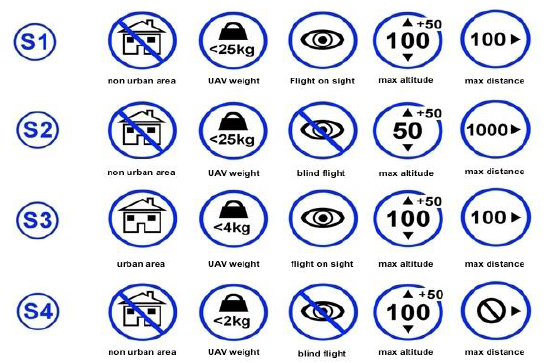
Figure 3: UAV flight rules utilized in